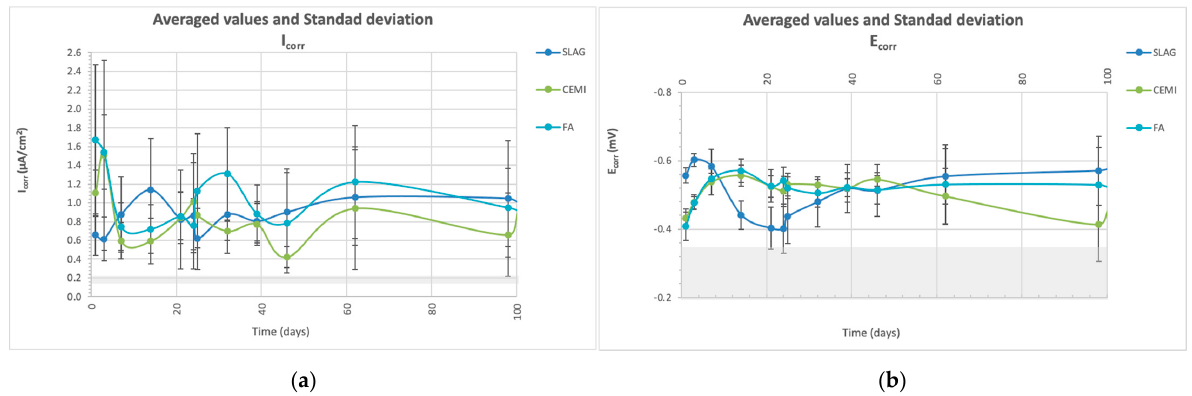
Figure 2. Electrochemical parameters ( a ) corrosion rate, I corr and ( b ) corrosion potential, E corr evolution. Averaged values and standard deviation. Threshold values that indicate the limit between passivation and corrosion are also indicated as a hatched area.